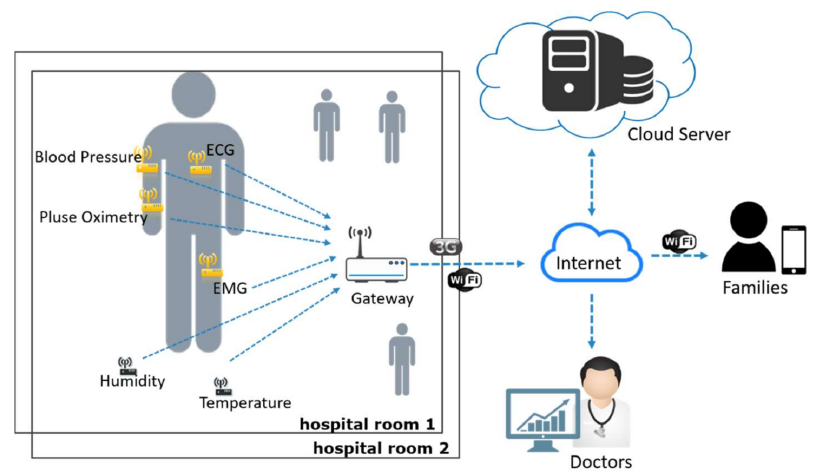
Figure 4. The possible IoT architecture for smart inpatient system scenario.